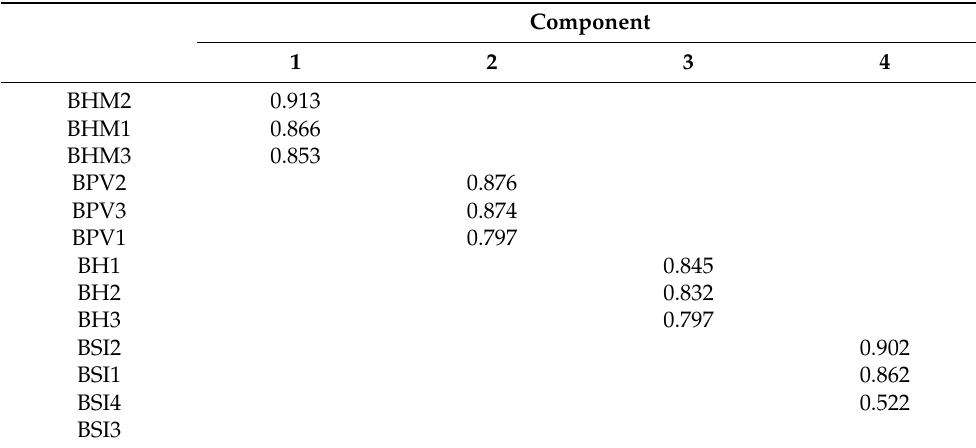
Table A2. Rotated component matrix for blogging (for the purposes of distinguishing between the professions, a prefix ‘B’ was added to the item identifiers).